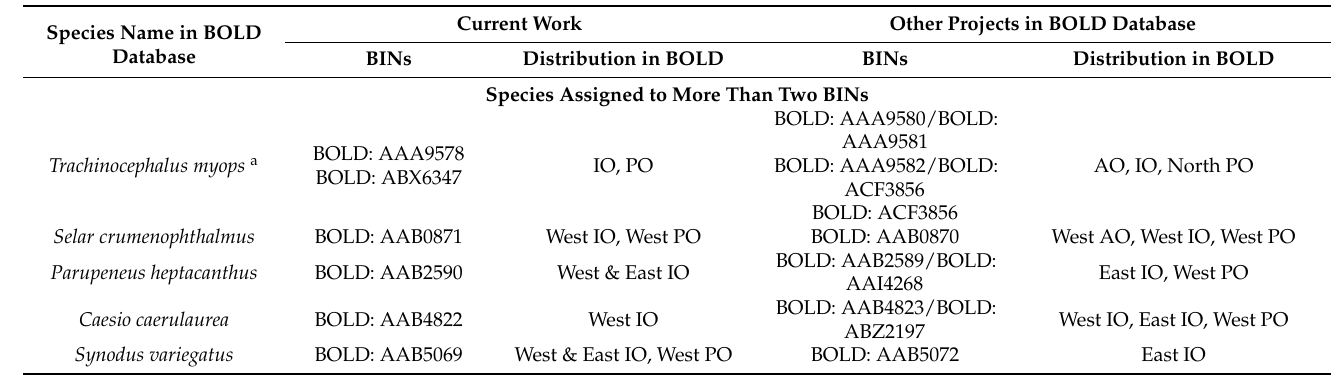
Table 2. Ambiguously identified species without separated origins of the specimens of each BIN, with IO: Indian Ocean, PO: Pacific Ocean, and AO: Atlantic